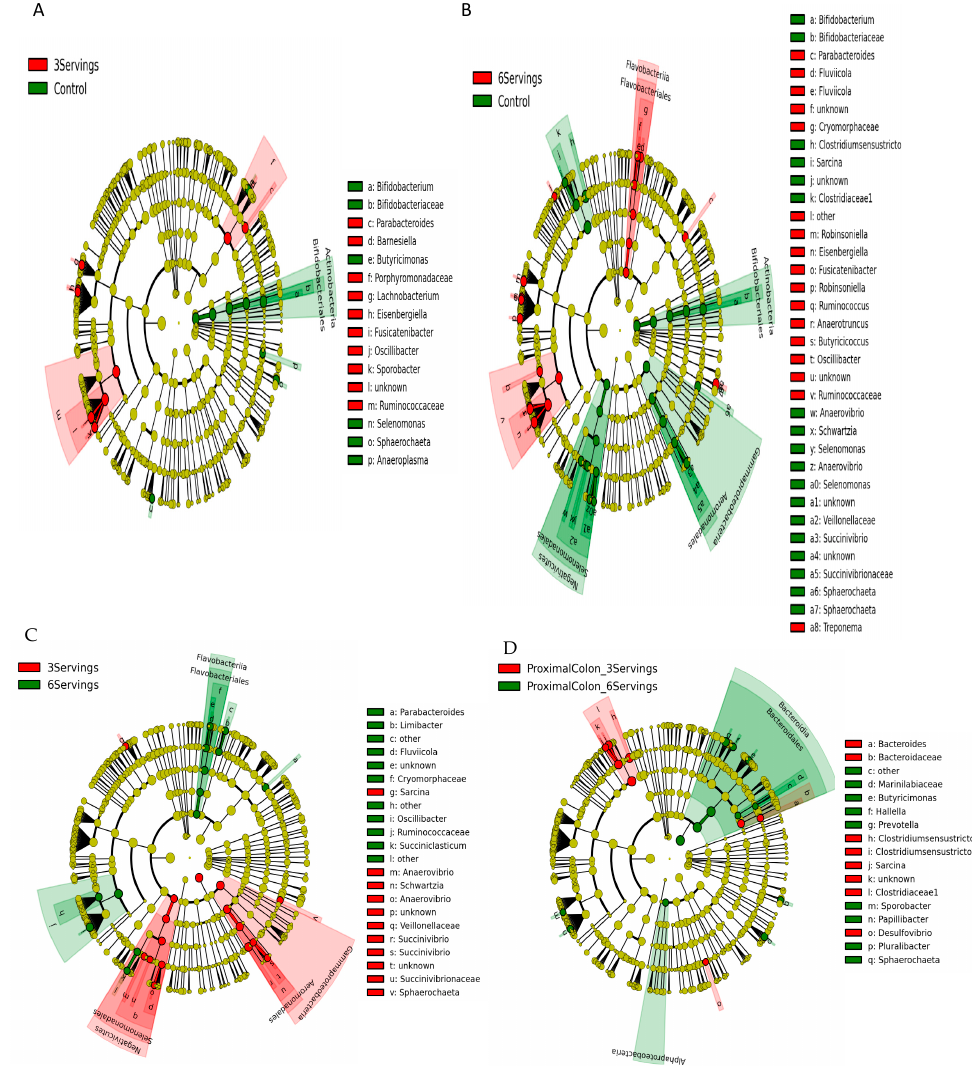
Figure 3. Linear discriminant analysis effect size (LEfSe) cladogram representing differentially abundant taxa in pig fecal and colonic microbiota. Enriched bacterial taxa in fecal microbiota of pigs fed three servings of white button (WB) mushrooms vs. control ( A ), six servings of WB mushrooms vs. control ( B ), three servings vs. six servings ( C ) and colonic microbiota from pigs fed three and six servings of WB mushrooms ( D ). Only taxa with linear discriminant analysis scores > 2 are presented. Each color in the pie chart represents the corresponding bacterial taxa in the legend. The LEfSe method was performed to determine individual taxa that were enriched (green) or depleted (red) within each dietary treatment comparison.